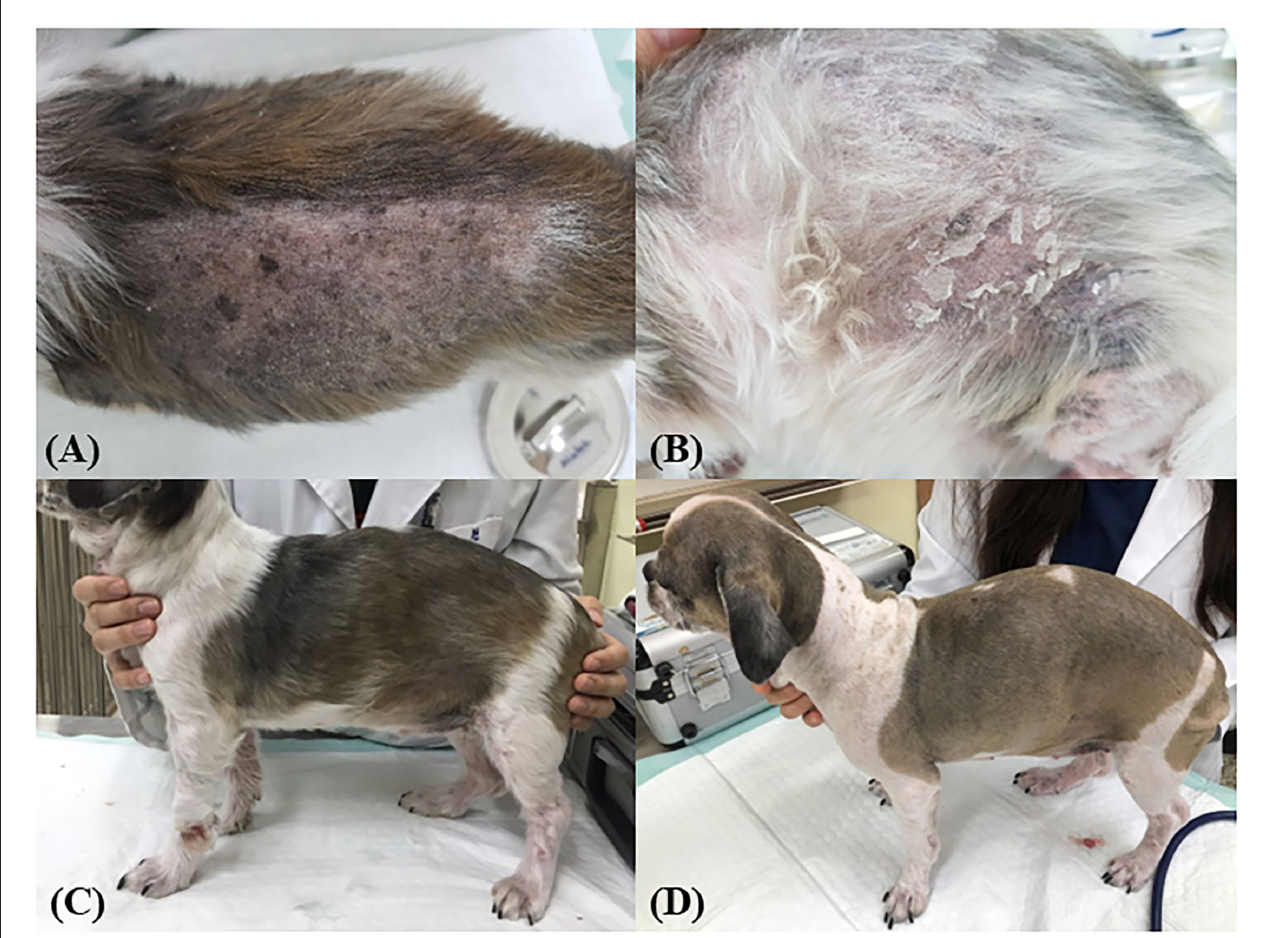
FIGURE2 Induction of autophagy improves skin lesions and hair quality in dogs with CAD. The alopecia on the left flank and many keratins were identified on the back and left flank at week 0 (A, B) . After 4 weeks, the lesions and the hair quality were improved (C) . At week 8, improved lesions were maintained (D)